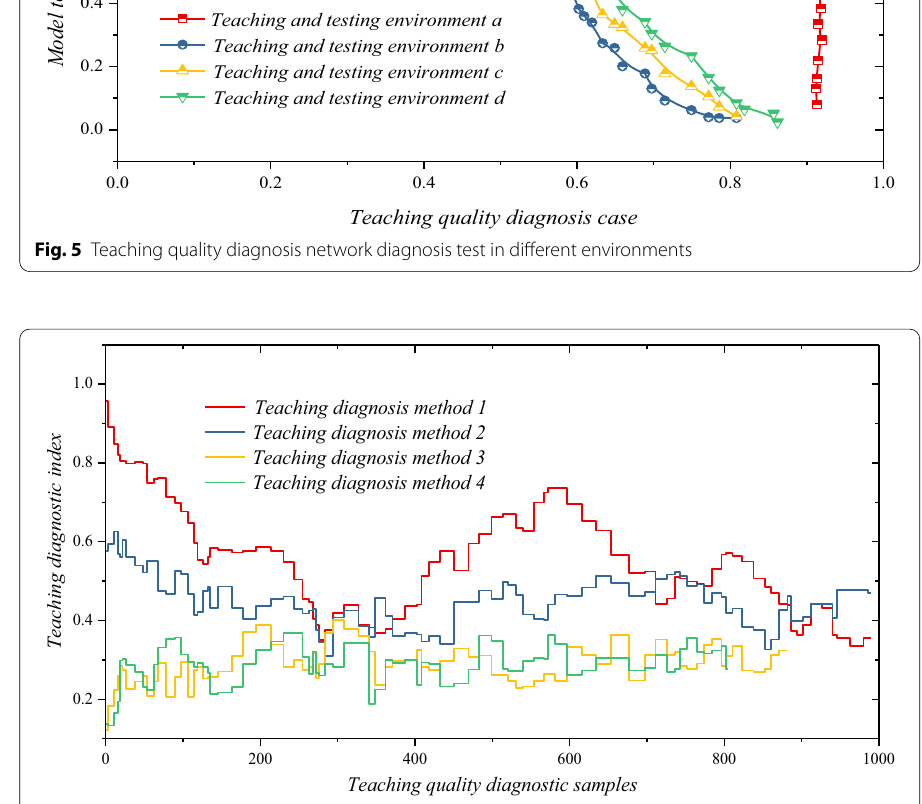
Fig. 6 Comparison test of the diagnosis success rate of the teaching quality diagnosis